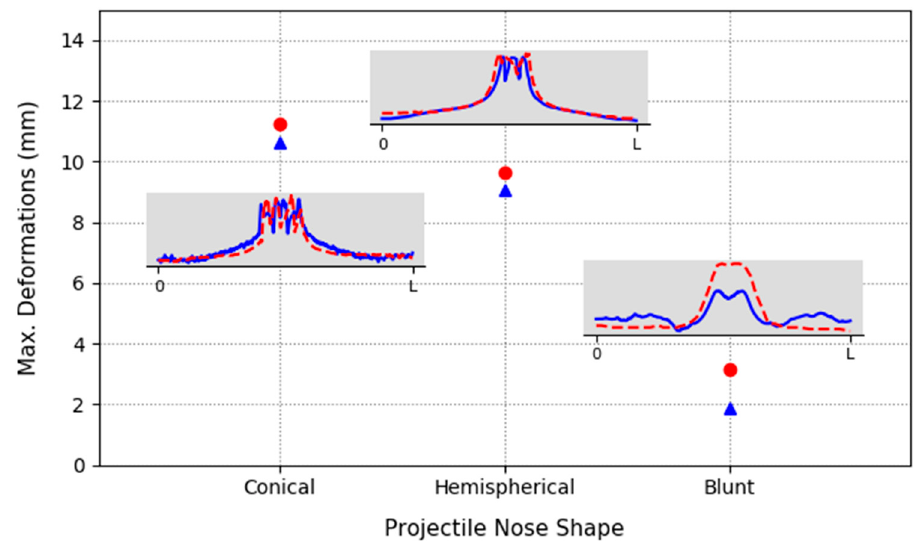
Figure 16. Maximum deformations for each projectile: circles—discontinued line (experimental measurements), triangles—continued line (numerical model).